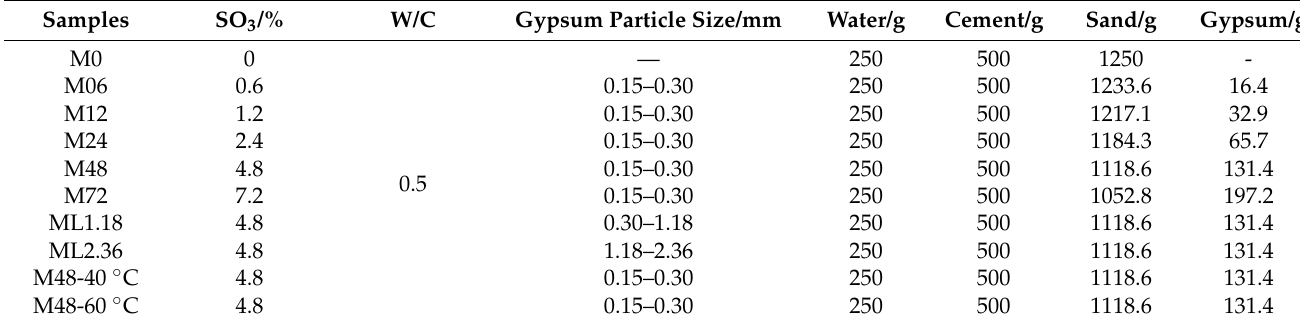
Table 5. Mix proportion of cement